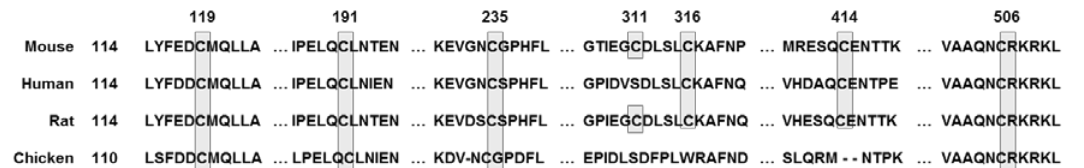
Figure 2. Conserved cysteine residue of Nrf2 across mouse, human, rat, and chicken; cysteine residues shaded and boxed.